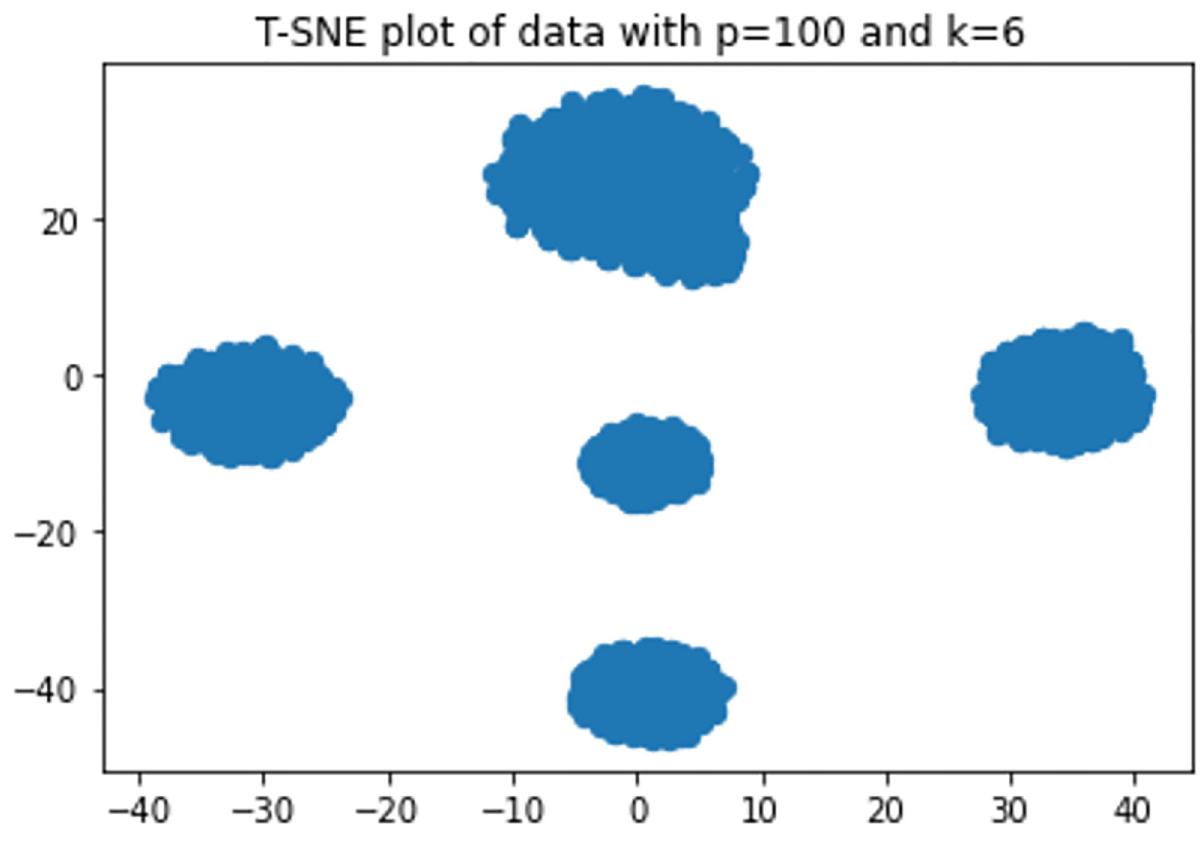
Fig 8. T-SNE plot of data with p = 100 and k =